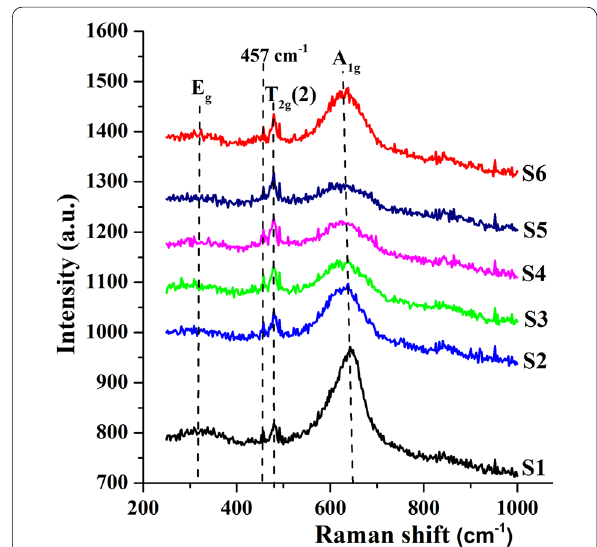
Fig. 4 Magnetic hysteresis loops of the samples with 0 inset shows the hysteresis loops on an enlarged scale; The lower inset shows M versus 1/ H curves in high magnetic